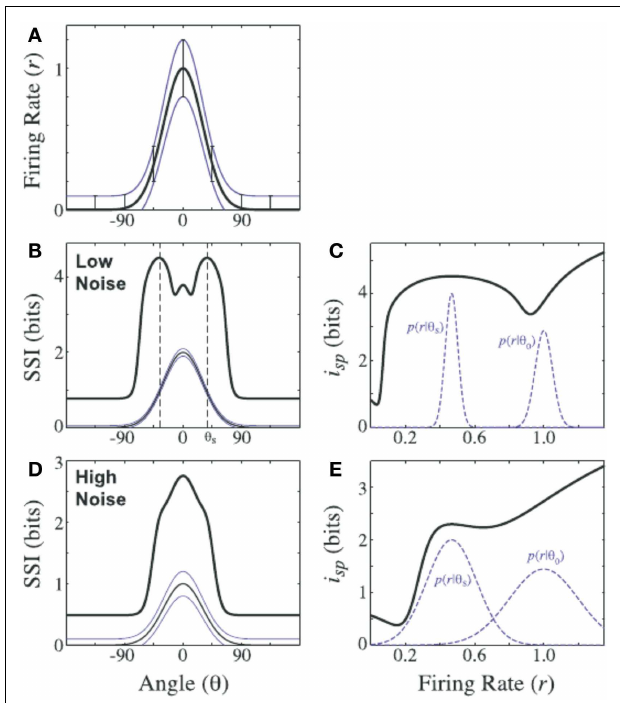
FIGURE 1 | Stimulus specific surprise ( i sp ) and stimulus specific information ( i SSI ) of an orientation tuned model neuron under two different noise regimes . (A) Tuning curve: mean firing rate (thick line), SD (thin lines) versus stimulus orientation ( Θ ). Repeated in for (B,D) for clarity. (B) The stimulus specific information i SSI (indicated as SSI) is maximal in regions of high slope of the tuning curve for the low noise case; (D) for the high noise case i SSI (indicated as SSI) is maximal at the peak of the tuning curve. (C,E) The corresponding values of the stimulus specific surprise i sp and the relevant conditional probability distributions. Figure reproduced from Butts and Goldman (2006). Creative Commons (CC BY) Attribution